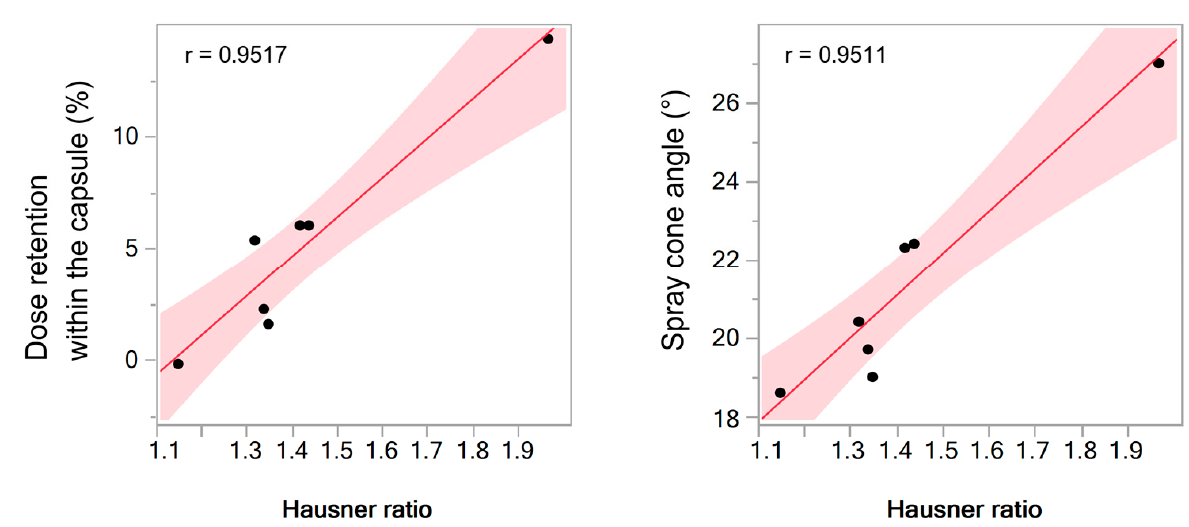
Figure 6. Correlation between dose percentage retained within the capsule and Hausner ratio ( left ; Pearson’s coefficient of 0.9517) and between spray cone angle and Hausner ratio ( right ; Pearson’s coefficient of 0.9511) established based on statistical analysis of data for DSP-MS, mannitol, lactose and DSP-MS blends with mannitol or lactose at weight ratios of 1:19 and 1:9. The spray cone angle for all investigated powders ranged between 19.6 ± 1.0° and 26.5 ± 0.3° (Figure 7). Mixing of DSP-MS with inert carrier resulted in decrease in spray cone angle in relation to DSP-MS alone. Spray cone angle was shown to be related to pow- der flow properties as it decreased with the decrease in Hausner ratio. Statistical analysis performed on data for DSP-MS, mannitol, lactose and DSP-MS blends with mannitol or lactose at weight ratios of 1:19 and 1:9 revealed linear relationship between inspected var- iables, with Pearson’s coefficient of 0.9511 (Figure 6, right). The results obtained indicated smaller spray cone angle for DSP-MS blends with mannitol in relation to those with lac- tose which is advantageous as, generally, smaller spray cone angles increase the chance for drug delivery beyond the nasal valve [29].